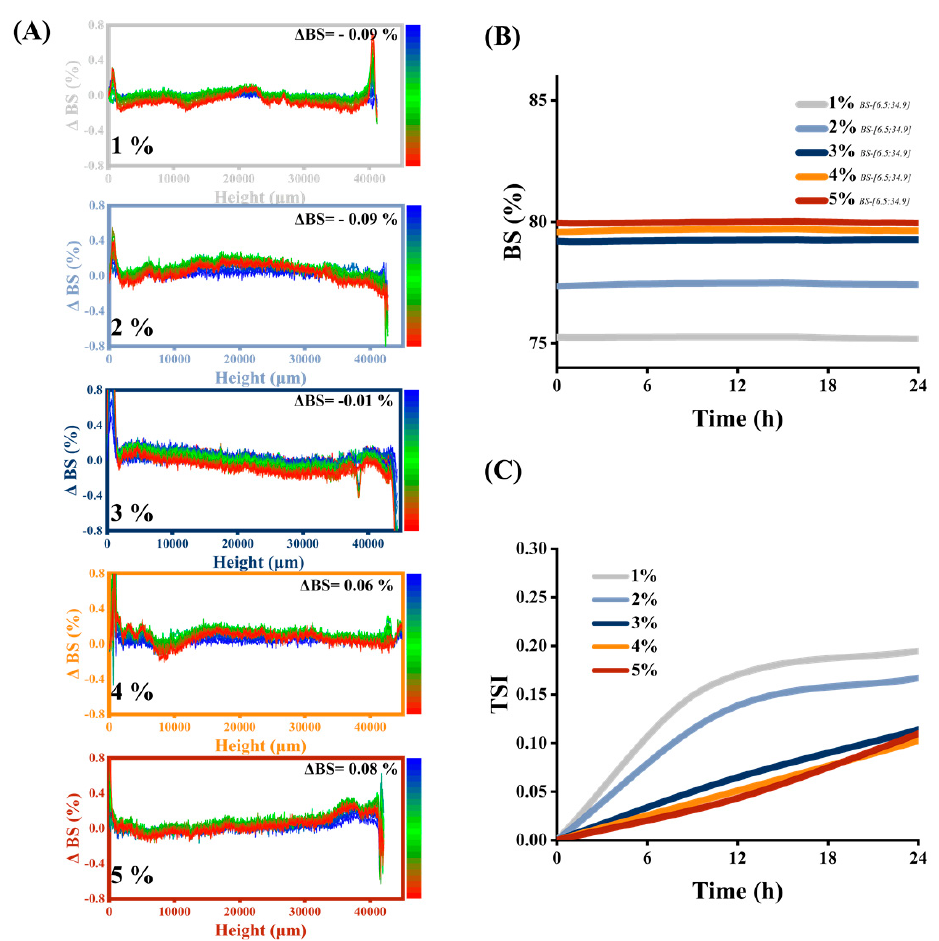
Figure 5. ( A ) Backscattered light rate (%) of change spectrum, ( B ) backscattered light (%) at the same coordinates and ( C ) TURBISCAN stability index of HIPEs stabilized by 1–5 wt% MPPI.